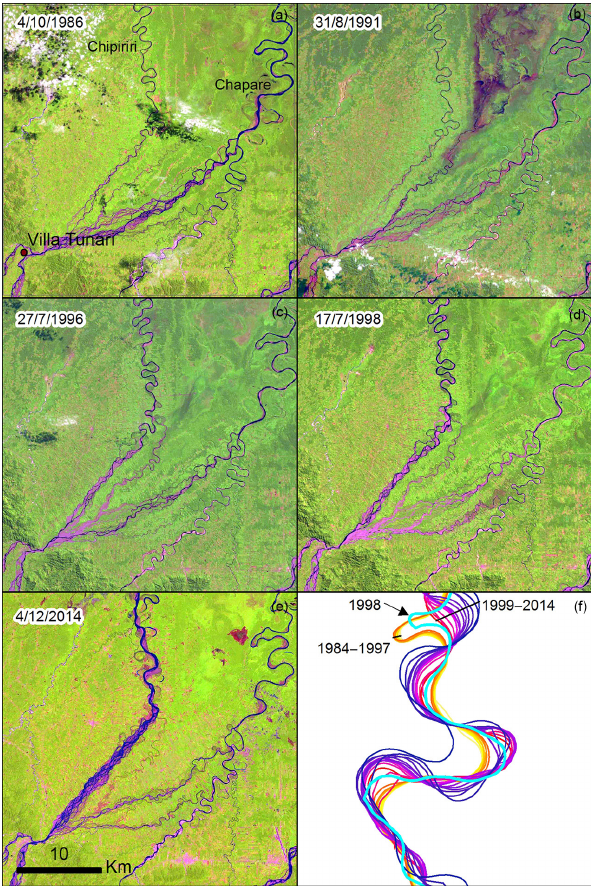
Figure 3. Río Chipiriri and río Chapare. From the fan apex in Villa Tunari, several braided courses converge to form the Chipiriri and the Chapare rivers. Landsat images taken at different times show that since 1998 the Chiripiri has been taking an increasingly larger share of the total surface water. Inset (f) shows that, since 1997, the increase in the sedimentary load has caused a marked increase in the channel width and normalized meander migration rate (Mr) of the Chipiriri. The latter has increased from 0.0122 to 0.0532. See locations in Fig.